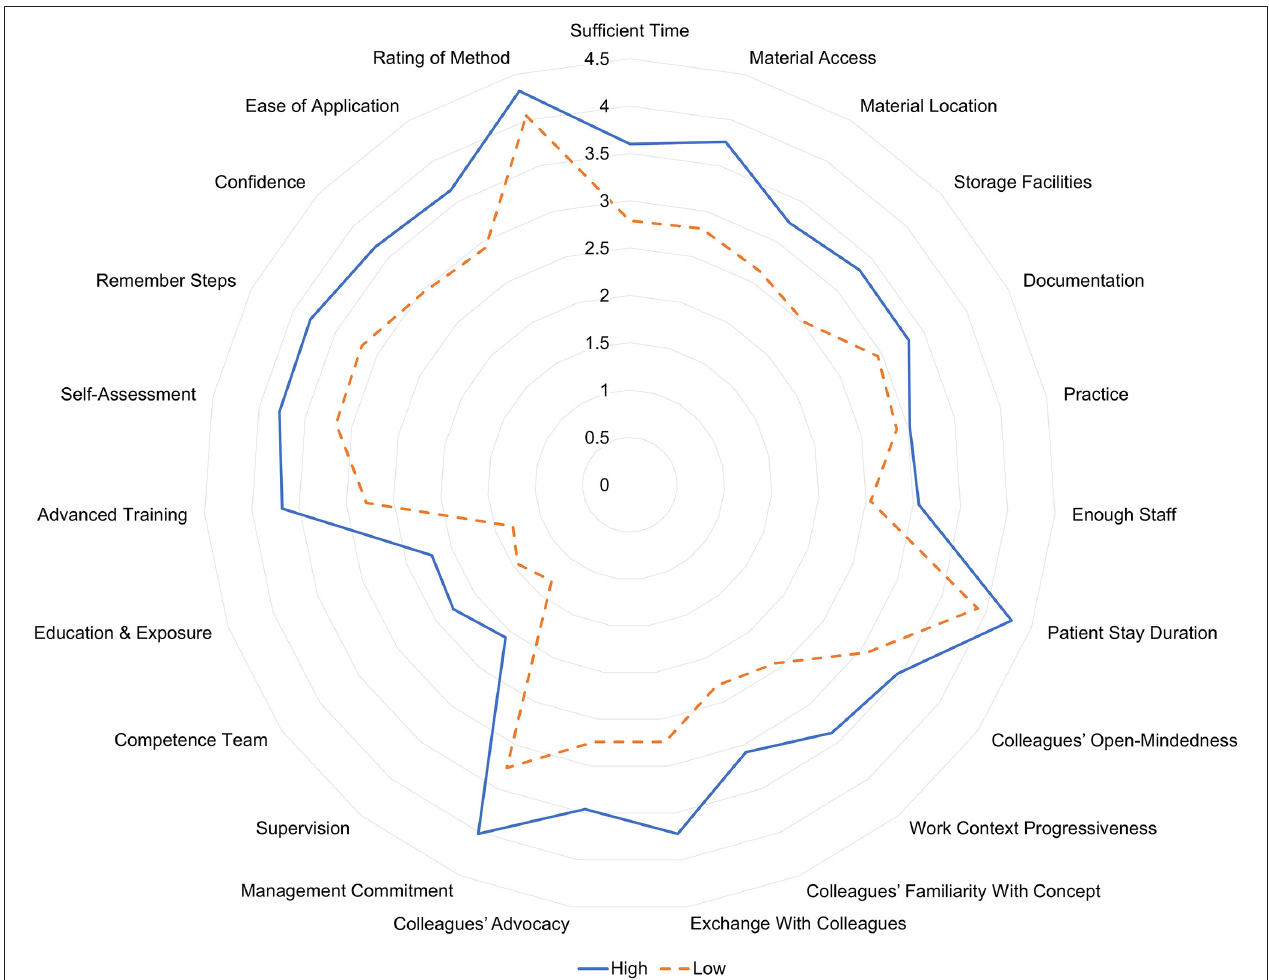
FIGURE 2 | Comparison of item averages between the high LiN-use group and the low LiN-use group, derived by a median